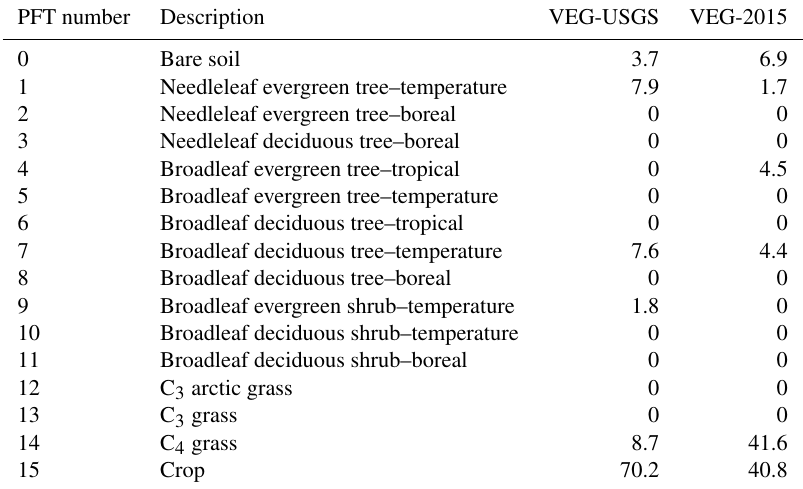
Table 2. The domain averaged fractions of PFTs in two vegetation datasets.